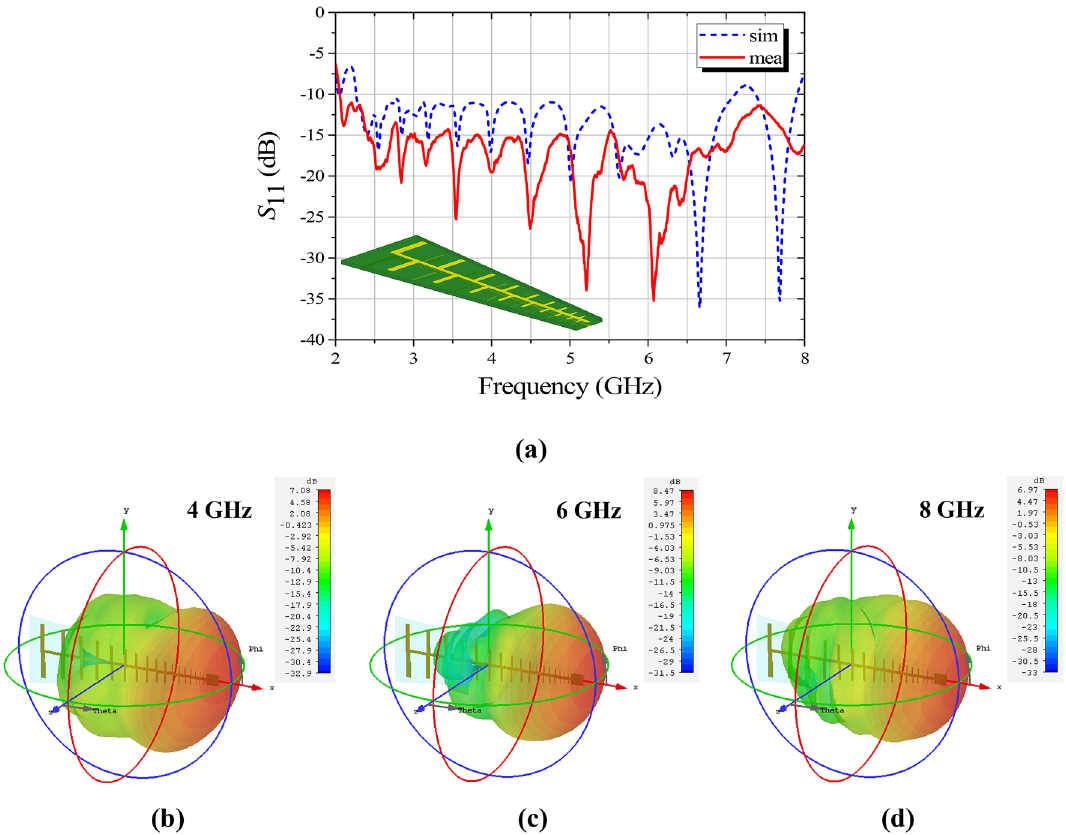
Figure 9. The performance of the feeding LPDA. ( a ) Simulated and measured S 11 of the LPDA. The inset on the lower left is the model of the proposed LPDA. ( b ) 3-D radiation pattern of the LPDA at 4 GHz. ( c ) 3-D radiation pattern of the LPDA at 6 GHz. ( d ) 3-D radiation pattern of the LPDA at 8